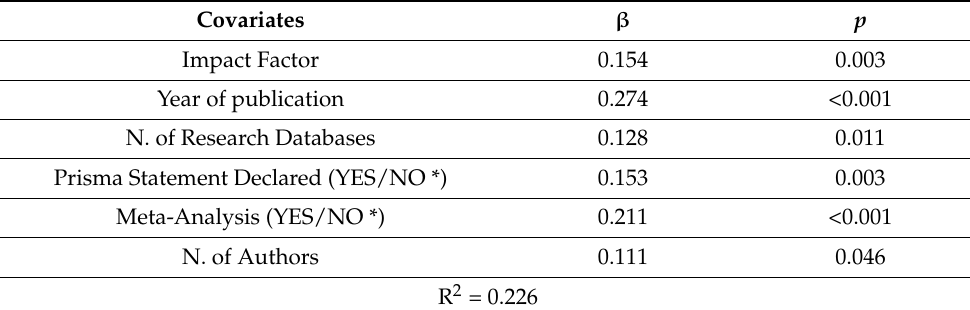
Table 4. Multivariate regression model of AMSTAR-2 score as outcome.